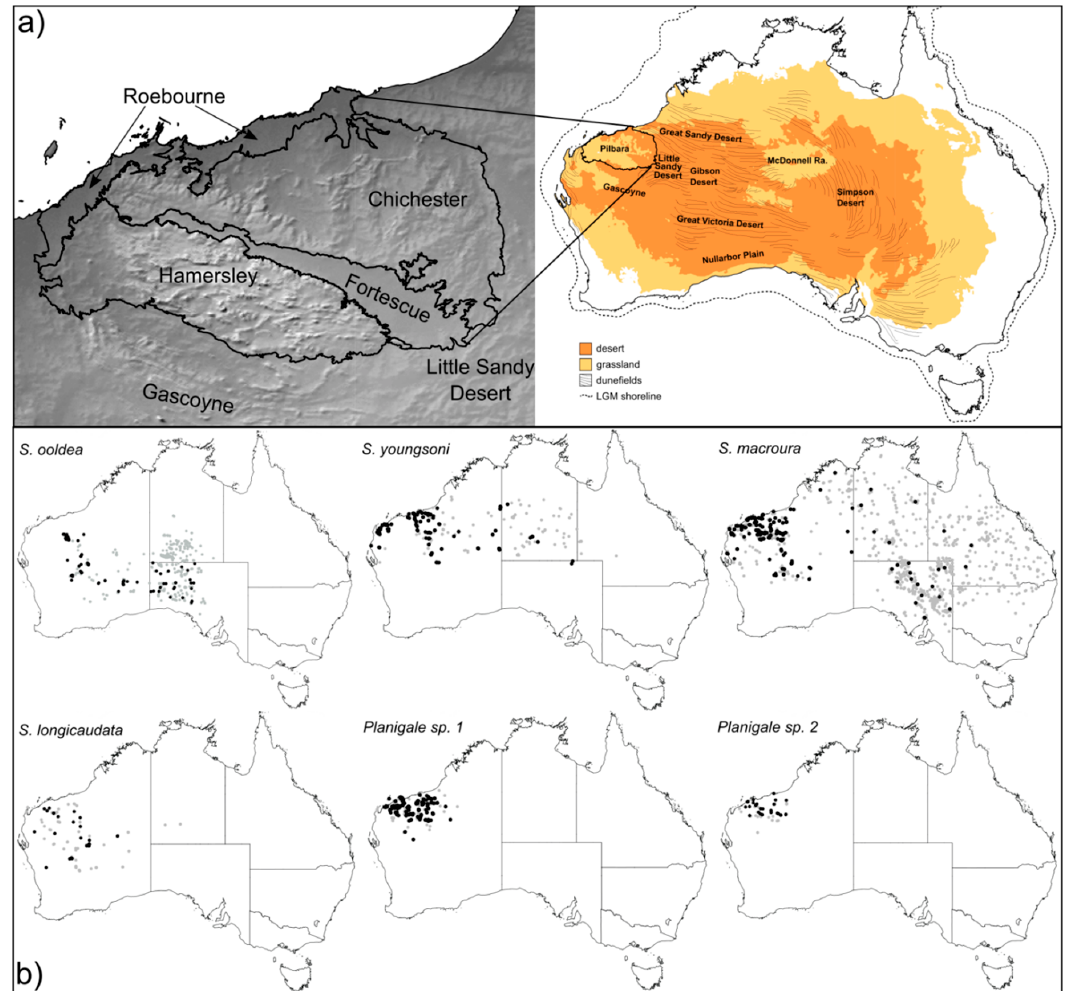
Figure 1. ( a ) Map of Australia showing arid regions labeled as Desert and Grassland (see [7]), location and direction of major dune systems [41], approximate location of Last Glacial Maxima (LGM) shoreline [5], and the Pilbara bioregion outlined in black, inset map shows digital elevation model and detail of Interim Biogeographic Regionalization for Australia (IBRA) within the Pilbara. ( b ) Distribution maps of the six species (gray points indicate vouchered specimens in Australian museums), and tissues sequenced in this study (black points). Non-WA records were accessed from Atlas of Living